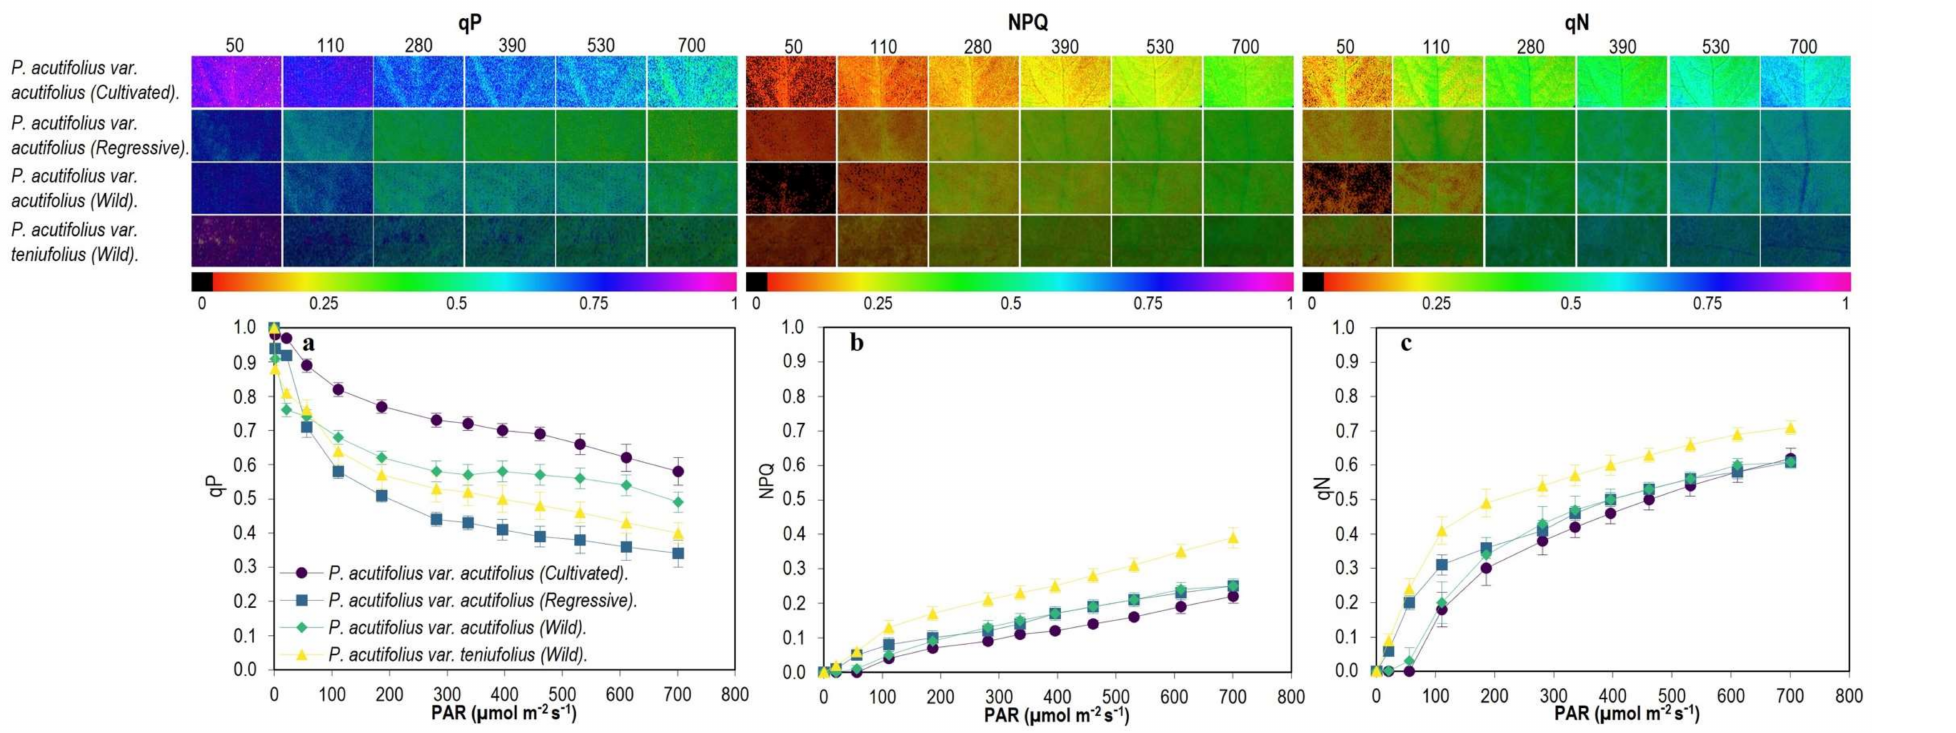
Figure 6. Different energy pathways as a function of PAR among the tepary bean genetic resource. ( a ) Photochemical quenching (qP), ( b ) non-photochemical quenching (NPQ), ( c ) coefficient of non-photochemical dissipation (qN). In the upper panel, gradient in color change from violet to red means higher to lower value for each variable. Means and error bars correspond to 20 AOI (area of interest) from four leaves of each accession, i.e., 5 AOI were tested on each